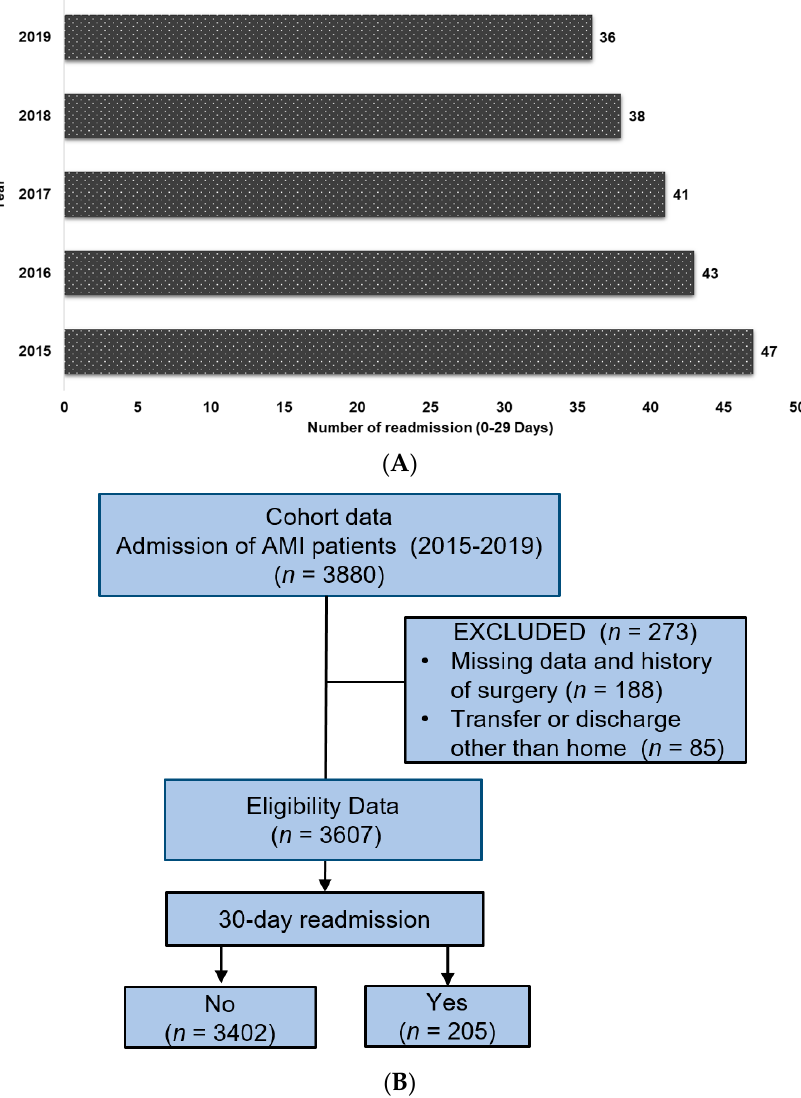
Figure 1. ( A ). Trends in 30-day acute myocardial infarction (AMI)-specific readmissions between 2015 and 2019. ( B ). Flow chart for selection process of study population.